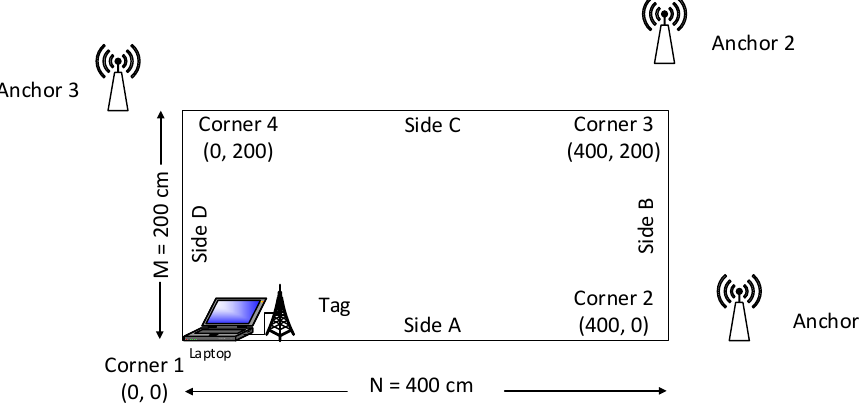
Figure 10. Floor plan for the testbed of UWB field experiment.